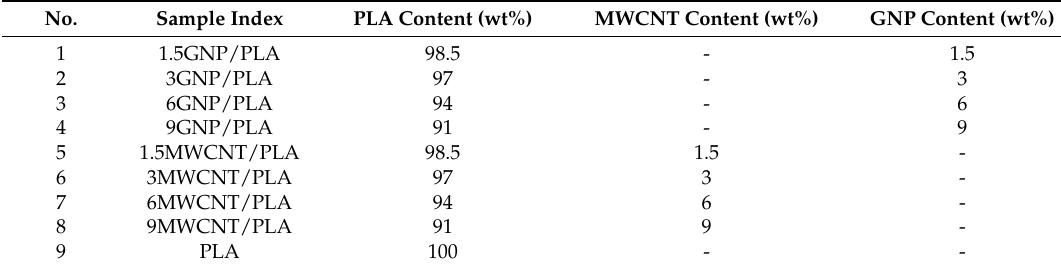
Table 1. List of PLA-based